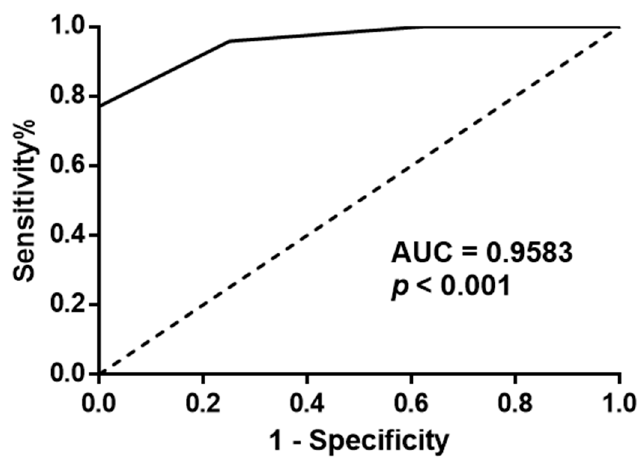
Figure 3. ROC curve of Gal-3 protein expression in normal and tumour prostate tissues. Area under the curve (AUC) = 0.9583(95% CI: 0.9042–1.012), p -value <